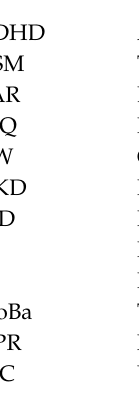
Figure S1: Conceptual model (simplified directed acyclic diagram (DAG)), Figure S2: Sex specific associations between maternal iodine intake from food (in non-supplement users) and child ADHD, Table S1: Associations between maternal iodine intake from food in participants who did not report use of supplemental iodine in the FFQ and risk of child ADHD diagnosis, Table S2: Association between maternal iodine intake from food in participants who did not report use of supplemental iodine in the FFQ) and score on maternally reported ADHD-symptoms at age 8